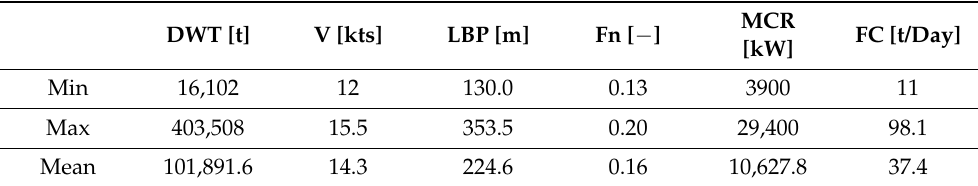
Table 1. Mean, minimum and maximum bulk carrier parameter values, where: MCR—total en- gine power, FC—daily fuel consumption, DWT—deadweight, V—speed, LBP—length between perpendiculars and Fn—Froude number.